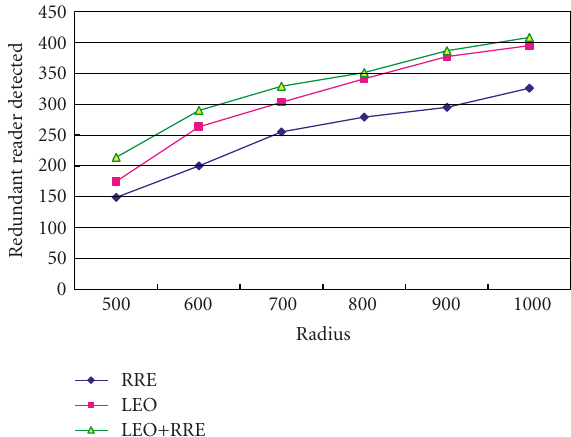
Figure 10: Comparison of redundant reader detected with network area 10000 × 10000, number of tags = 4000, and number of readers = 500.